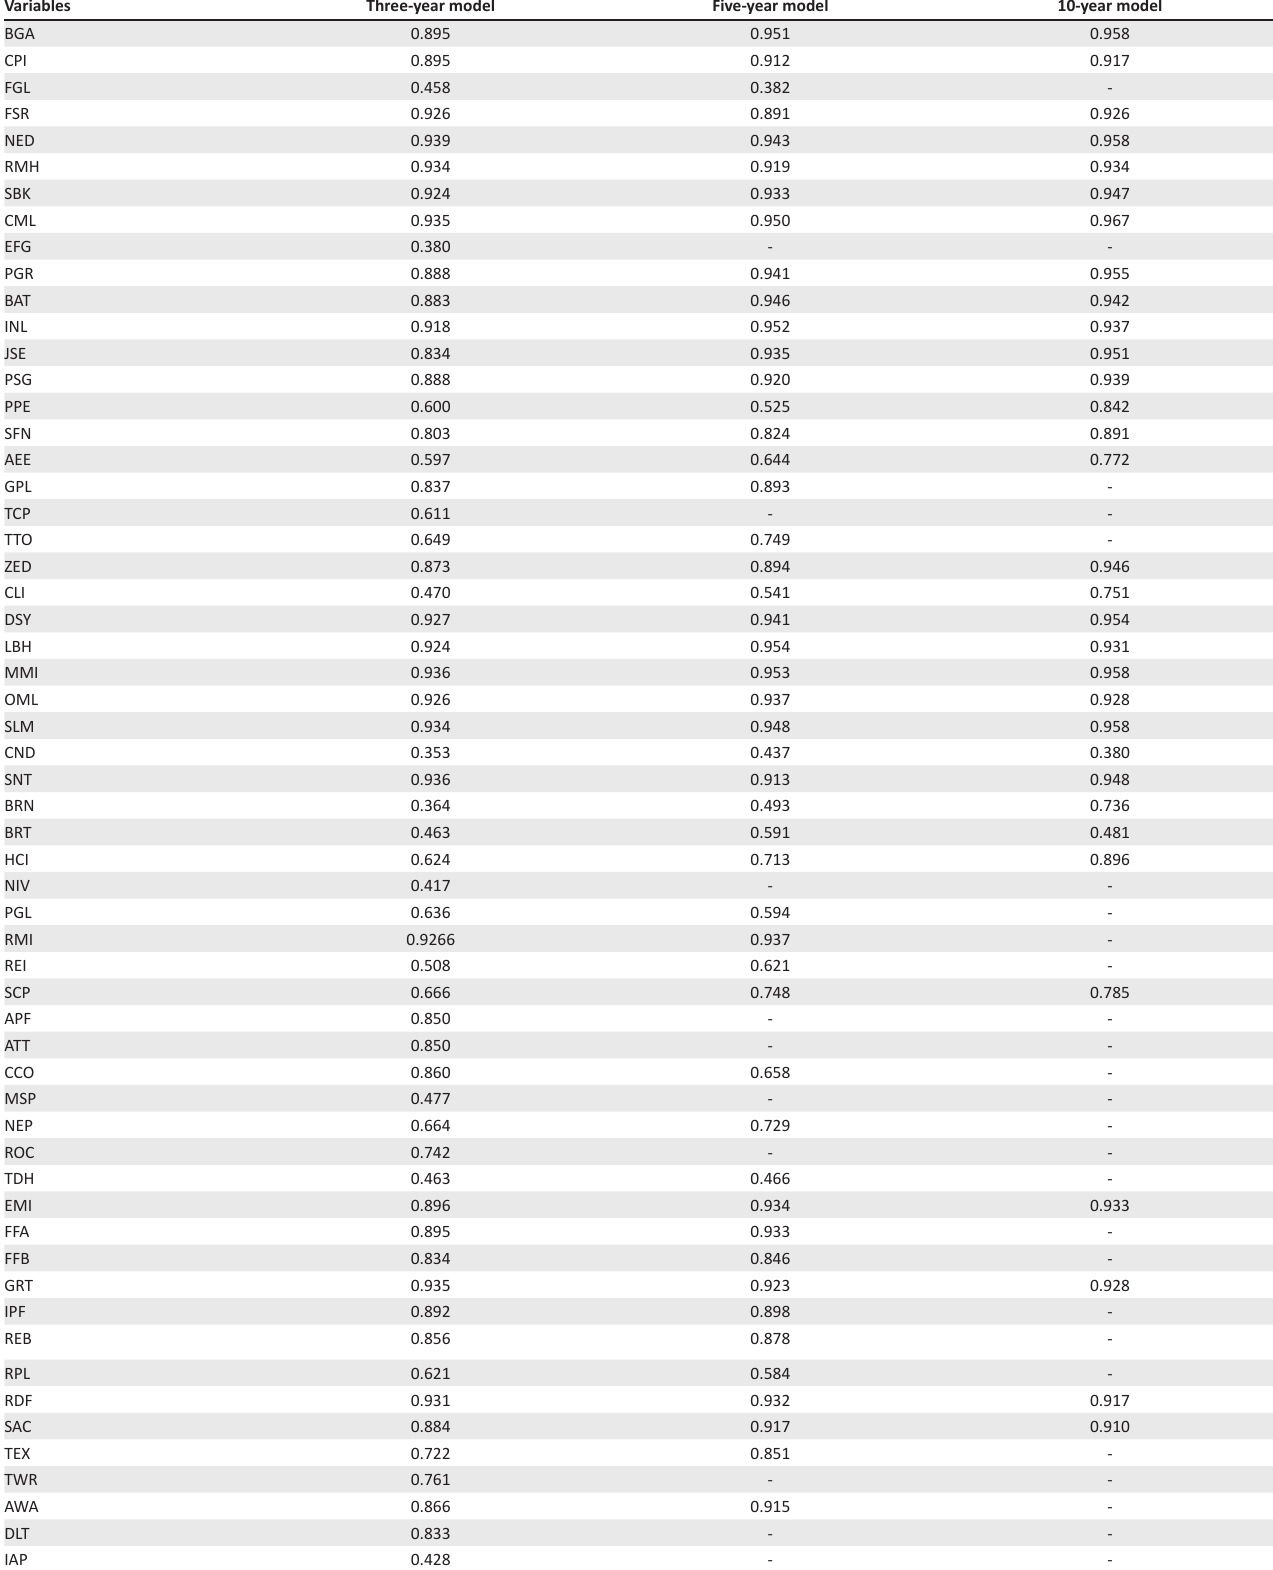
TABLE 1-A2: Kaiser–Meyer–Olkin measure of sampling